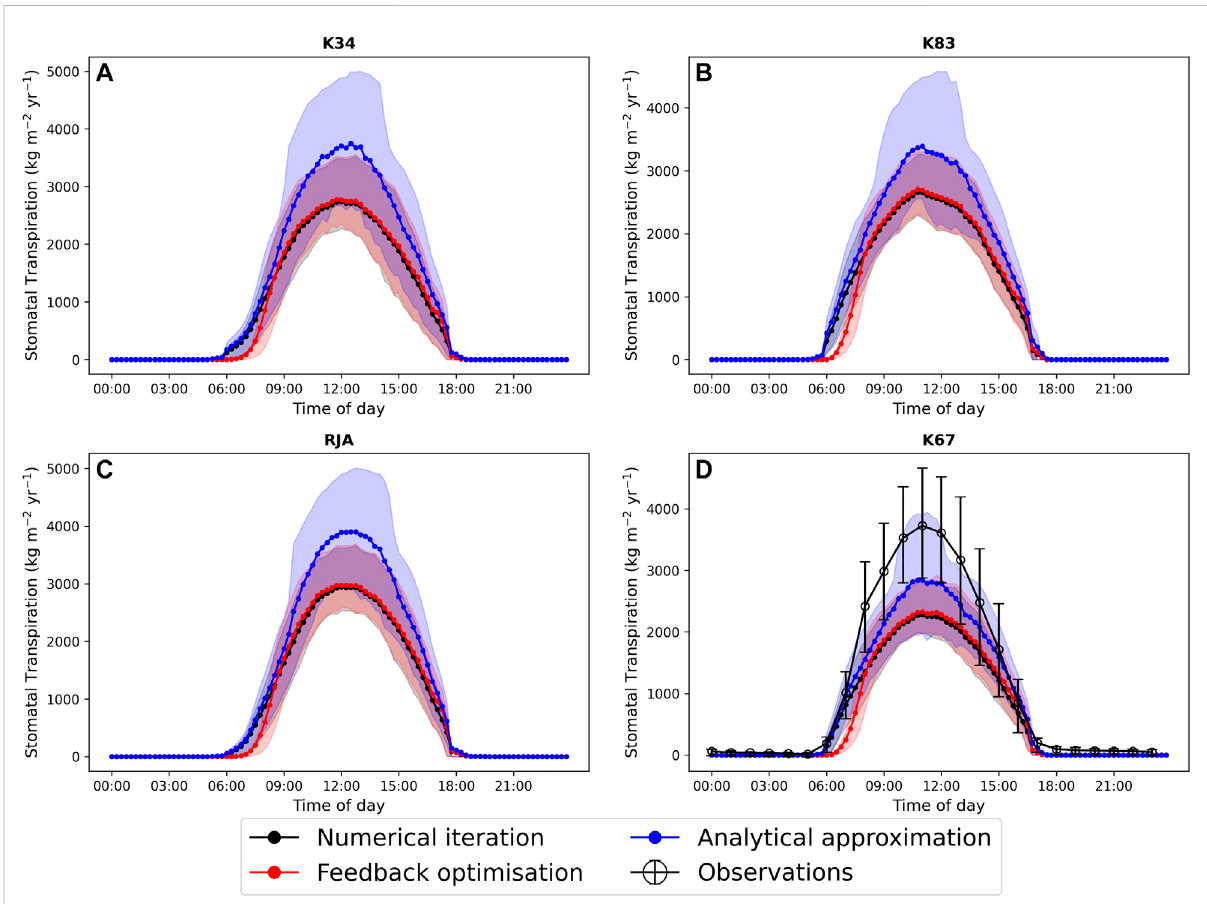
FIGURE 5 A comparison of the average diurnal cycle of predicted stomatal transpiration (kg H 2 O m − 2 yr − 1 ) from JULES-SOX solved using three different methods (1. Numerical iteration (black), 2. Feedback control (red), 3. A semi-analytical approximation (blue))) and observed transpiration at four sites in the Amazon rainforest. (A) LBA-K34 Reserva Cuieiras, Manaus Brazil; (B) LBA-K83 Tapajos National forest, Santarem Brazil; (C) LBA-RJA Reserva Jaru; (D) LBA-K67TapajosNationalforest,SantaremBrazil.ObserveddataisfromSaleskaetal.(2013).Errorbarsandshadedareasrepresentthe 25% and 75% uncertainty